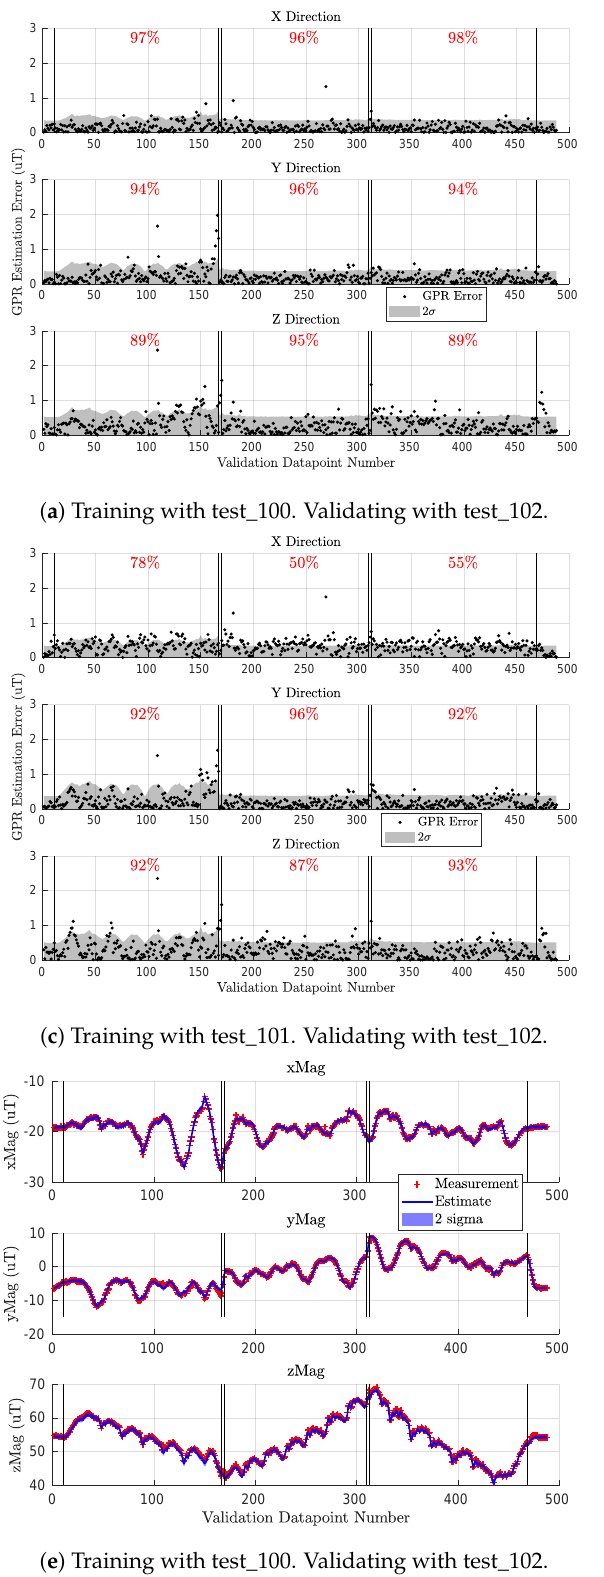
Figure 7. GPR-based magnetic field map error on ∼ 490 validation points from Scan- β . In order, the large segments separated by vertical bars are at altitudes 0.5 m, 1.5 m, and 2 m, respectively. For Figure 7a–d, the red percentage value shows how often the error is within the 2 σ uncertainty for each altitude